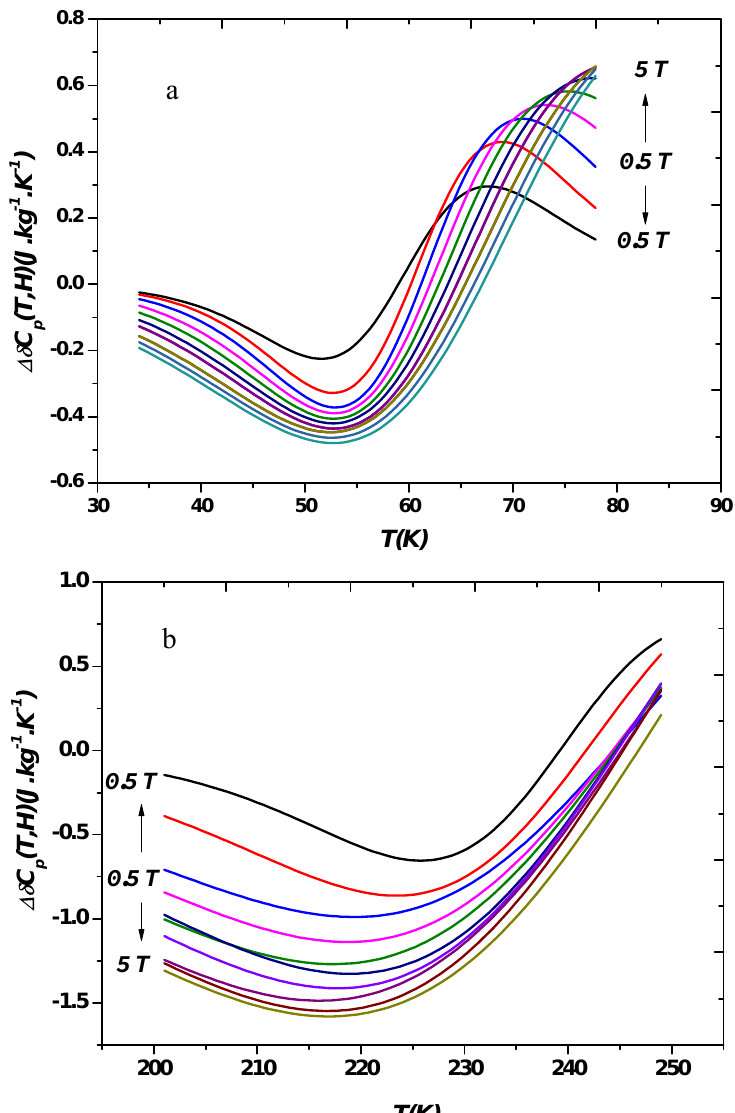
Figure 11. Change of the specific heat for SmNi 3 ( a ) and SmNi 2.2 Fe 0.8 ( b ) under several magnetic fields vs.